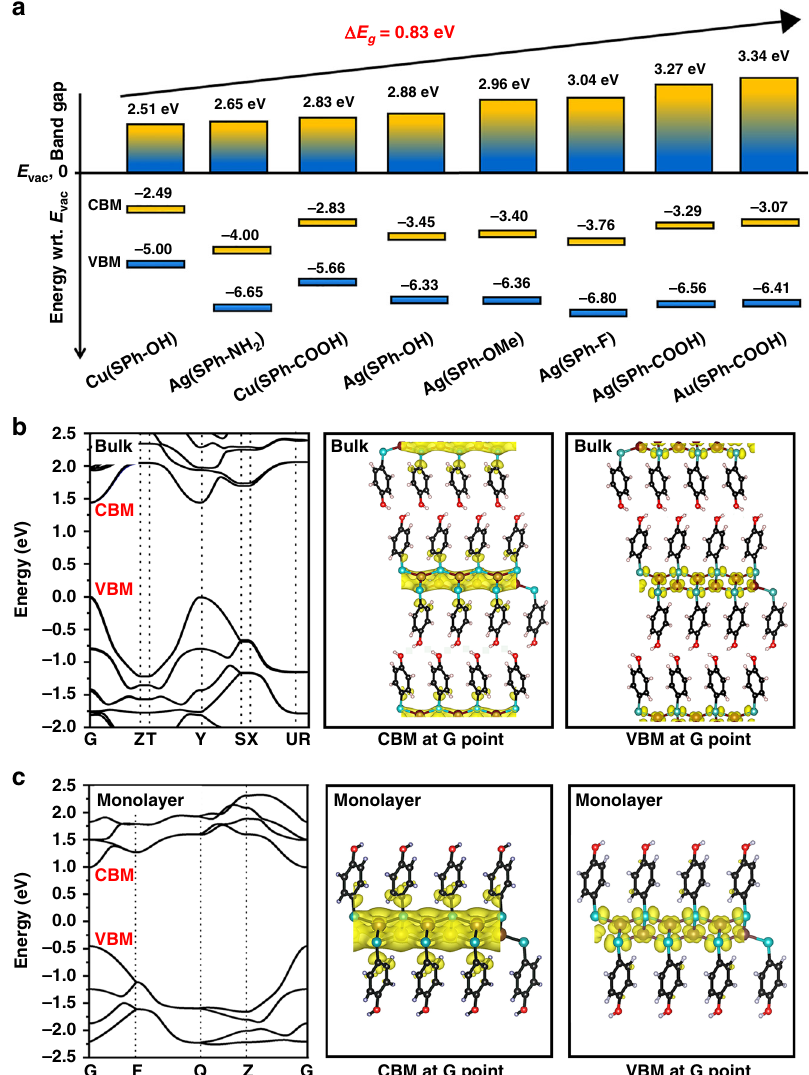
Fig. 3 Band gap modulation and band structure calculation of OMCs. a The band gap of OMCs modulated by changing the components (calculated from UV – vis diffuse re fl ectance spectra); b calculated band structure of bulk Cu(SPh-OH) and its corresponding VBM and CBM at Gamma (G) point; c calculated band structure of monolayer Cu(SPh-OH) and its corresponding VBM and CBM at Gamma (G)